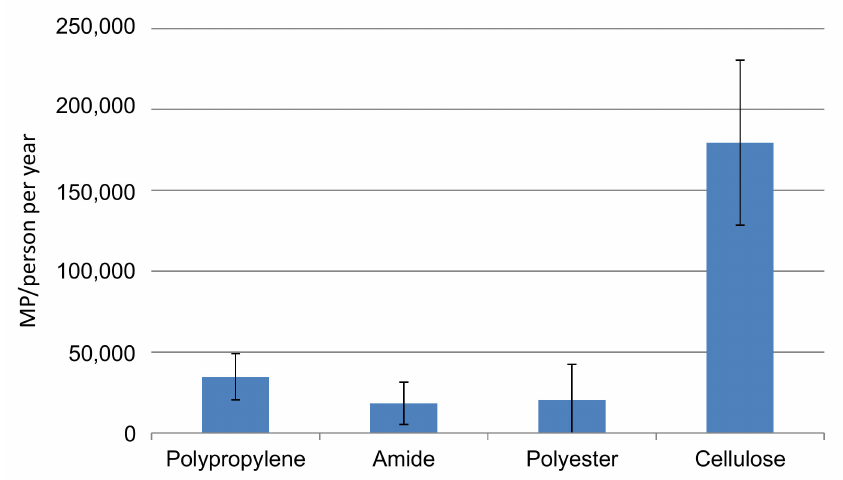
Figure 12. MP released per person/year considering that 10% of face masks used reach the aquatic environment. The data are an estimate based on the results of the current study, considering that each person wears a new mask every 2